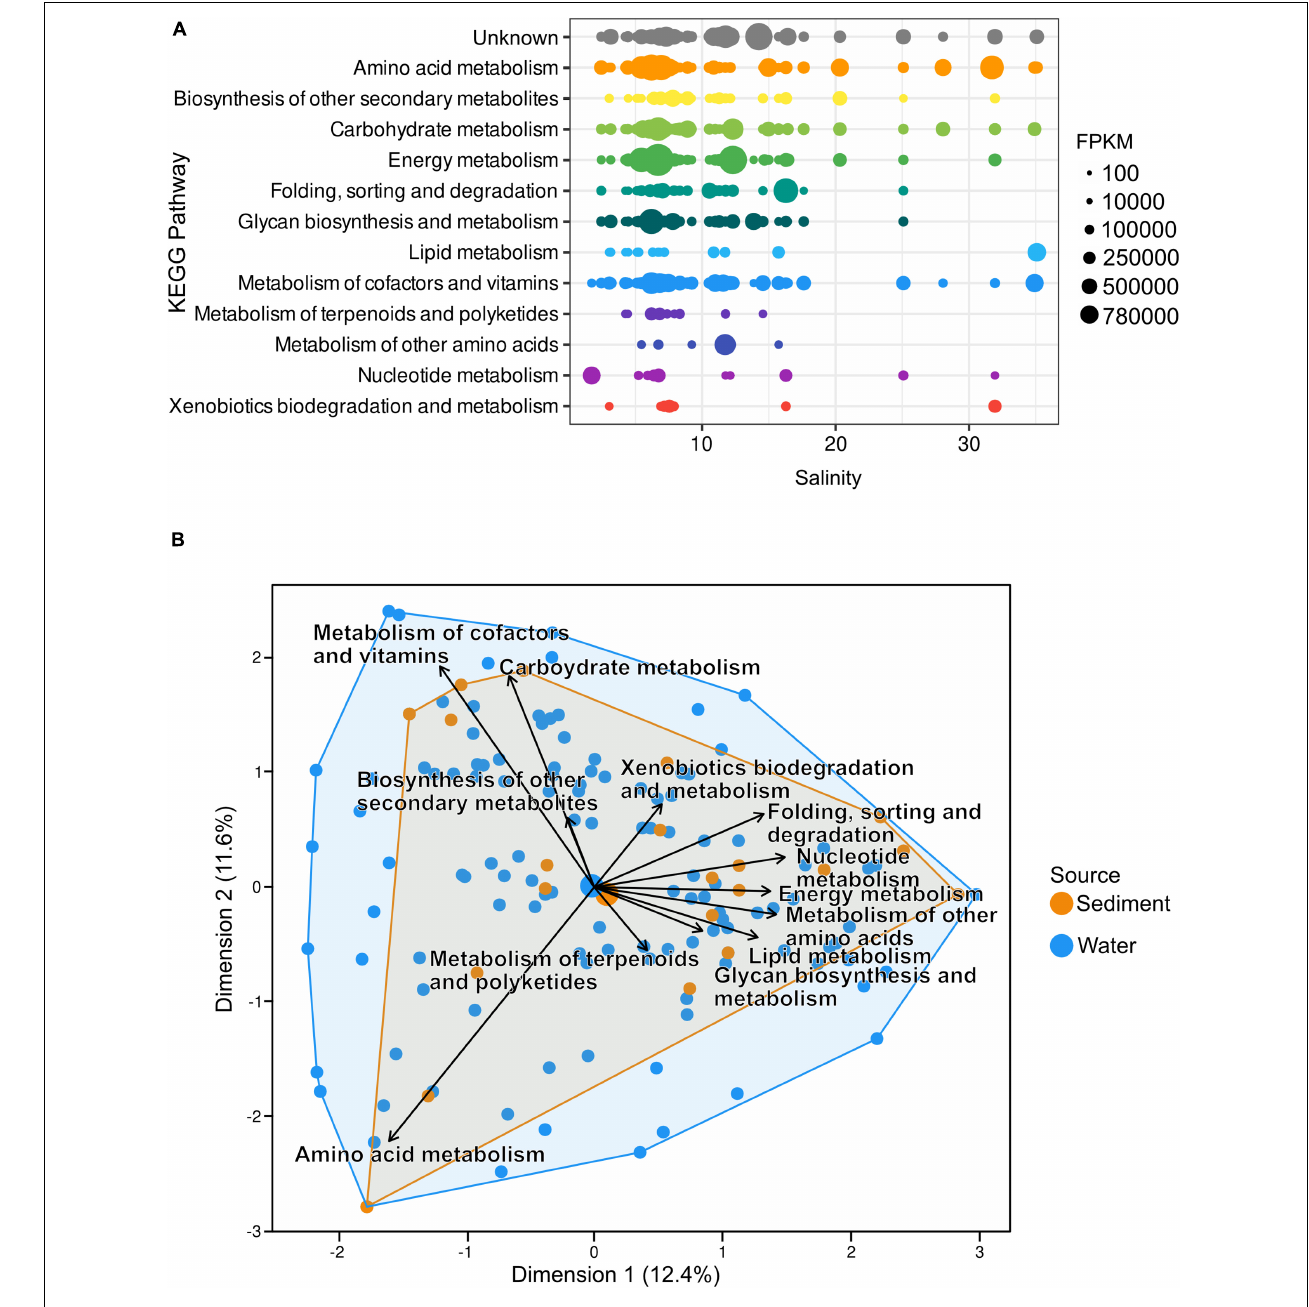
FIGURE 6 | (A) Distribution of AMGs along the salinity gradient of the Baltic Sea; both water and sediment samples are depicted together. The number of AMGs was normalized to AMG per million reads. (B) Principal component analysis of Hellinger transformed AMG counts shows most samples cluster close to the center of the ordination. However, vectors of metabolic pathways indicate no uniform presence of metabolic pathways at all